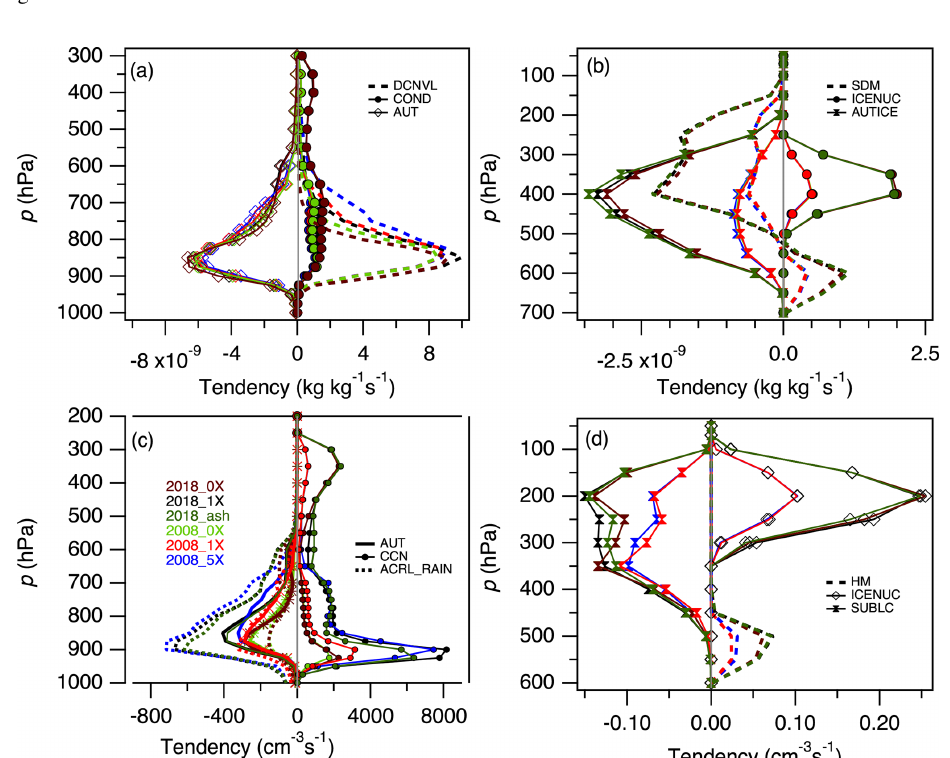
Figure 14. Comparison of dominant microphysical process rates for (a) liquid mass, (b) ice mass, (c) liquid number, and (d) ice number concentration. Color corresponds to the different experiments listed in Table